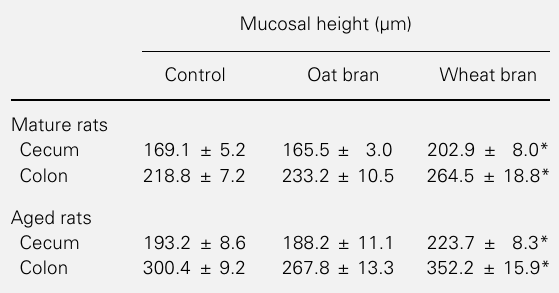
Table 2 - Effect of soluble (oat bran) and insoluble (wheat bran) fiber-rich diets on the mucosal height of colon and cecum of mature and aged